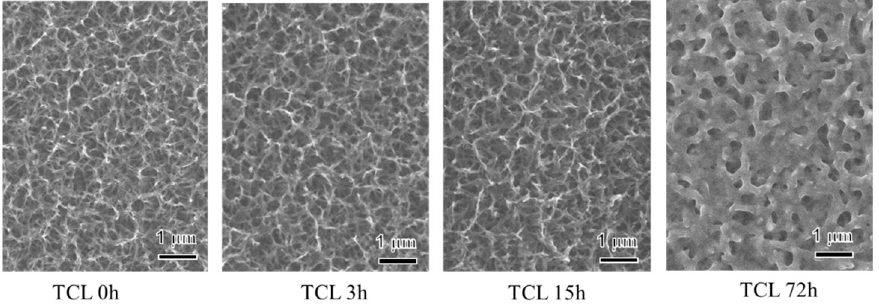
Figure 8. SEM images of the surfaces of the sample CT10G + MA + Ca without or with thermal cross-link treatment for periods of 3–72 h that were soaked in PBS for 7 days.